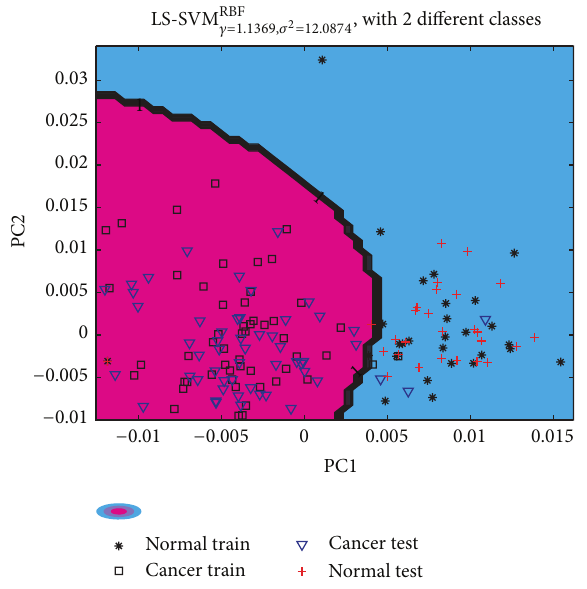
Figure 4: Visual expression of the optimal classification model of least-squares support vector machine using the first two principal components as input.